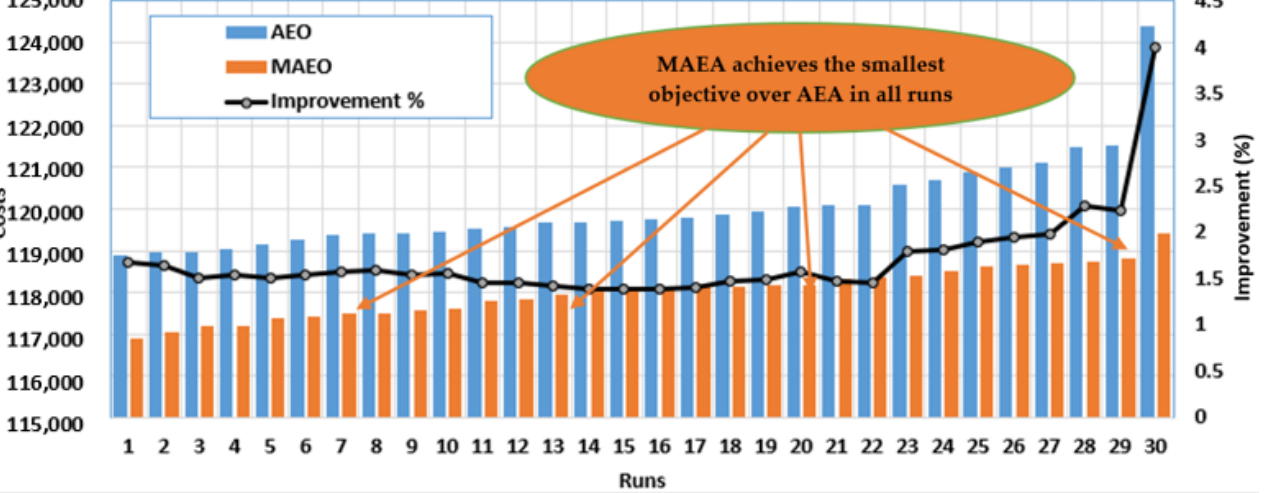
Figure 10. Obtained costs for all simulated runs of the proposed MAEA and the basic AEA of Case 3. Table 7. Robustness metrics of the proposed MAEA and the basic AEA of Case 3. Costs (USD/h) AEO Proposed MAEA